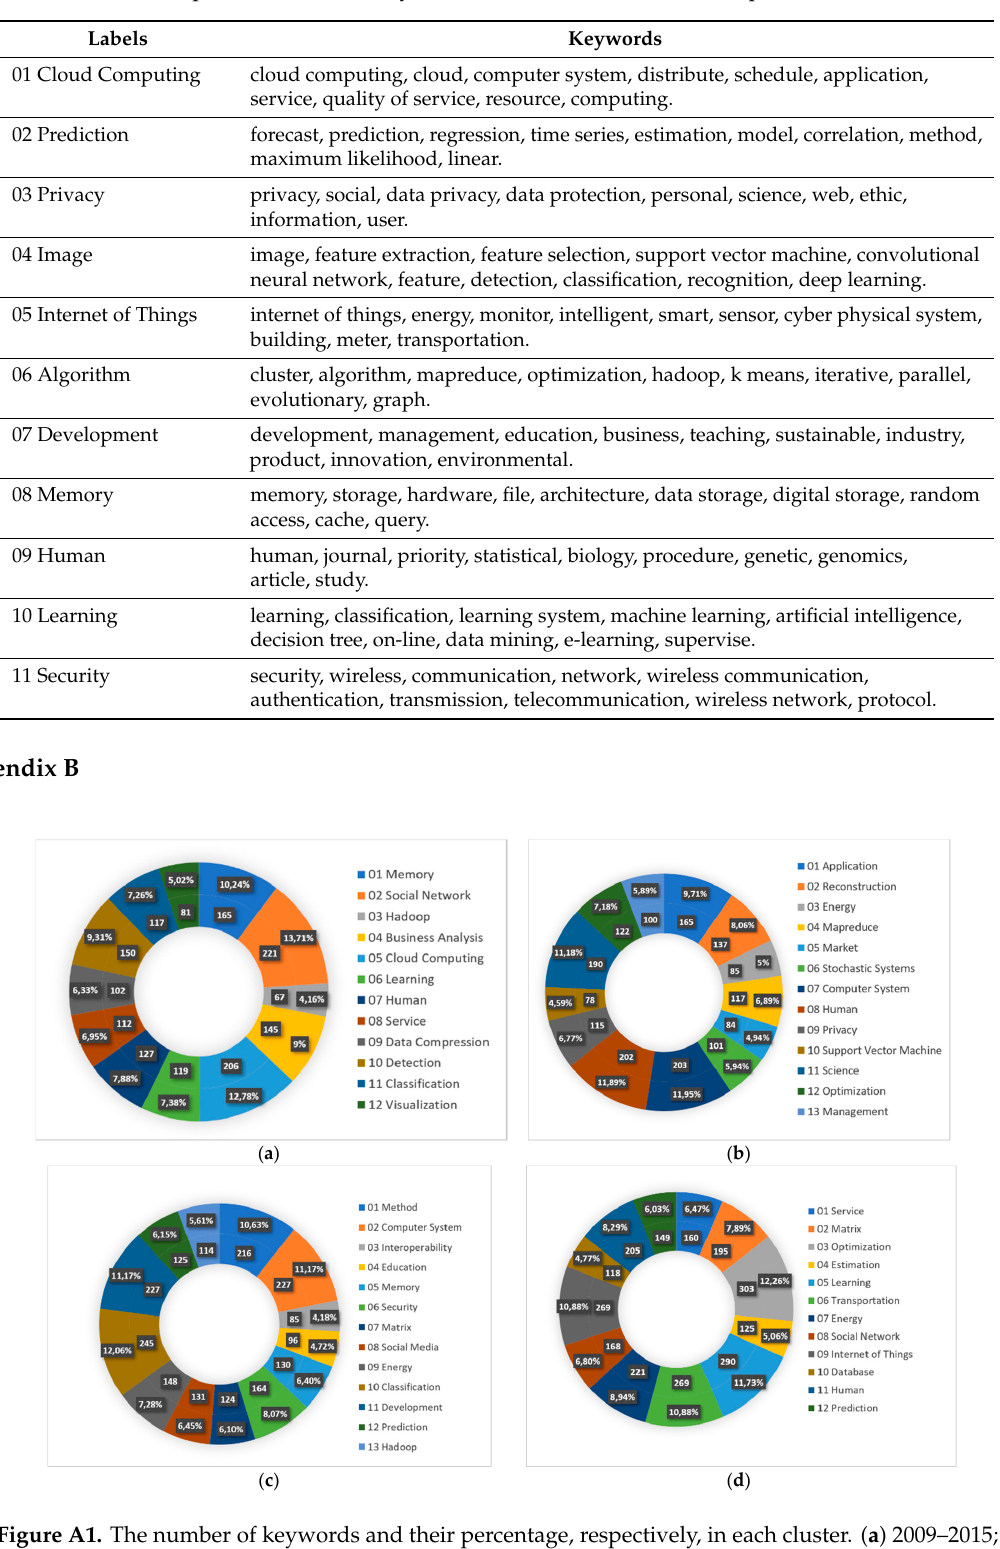
Table A1. Top 10 characteristic keywords in each cluster for the time period 2009–2018.